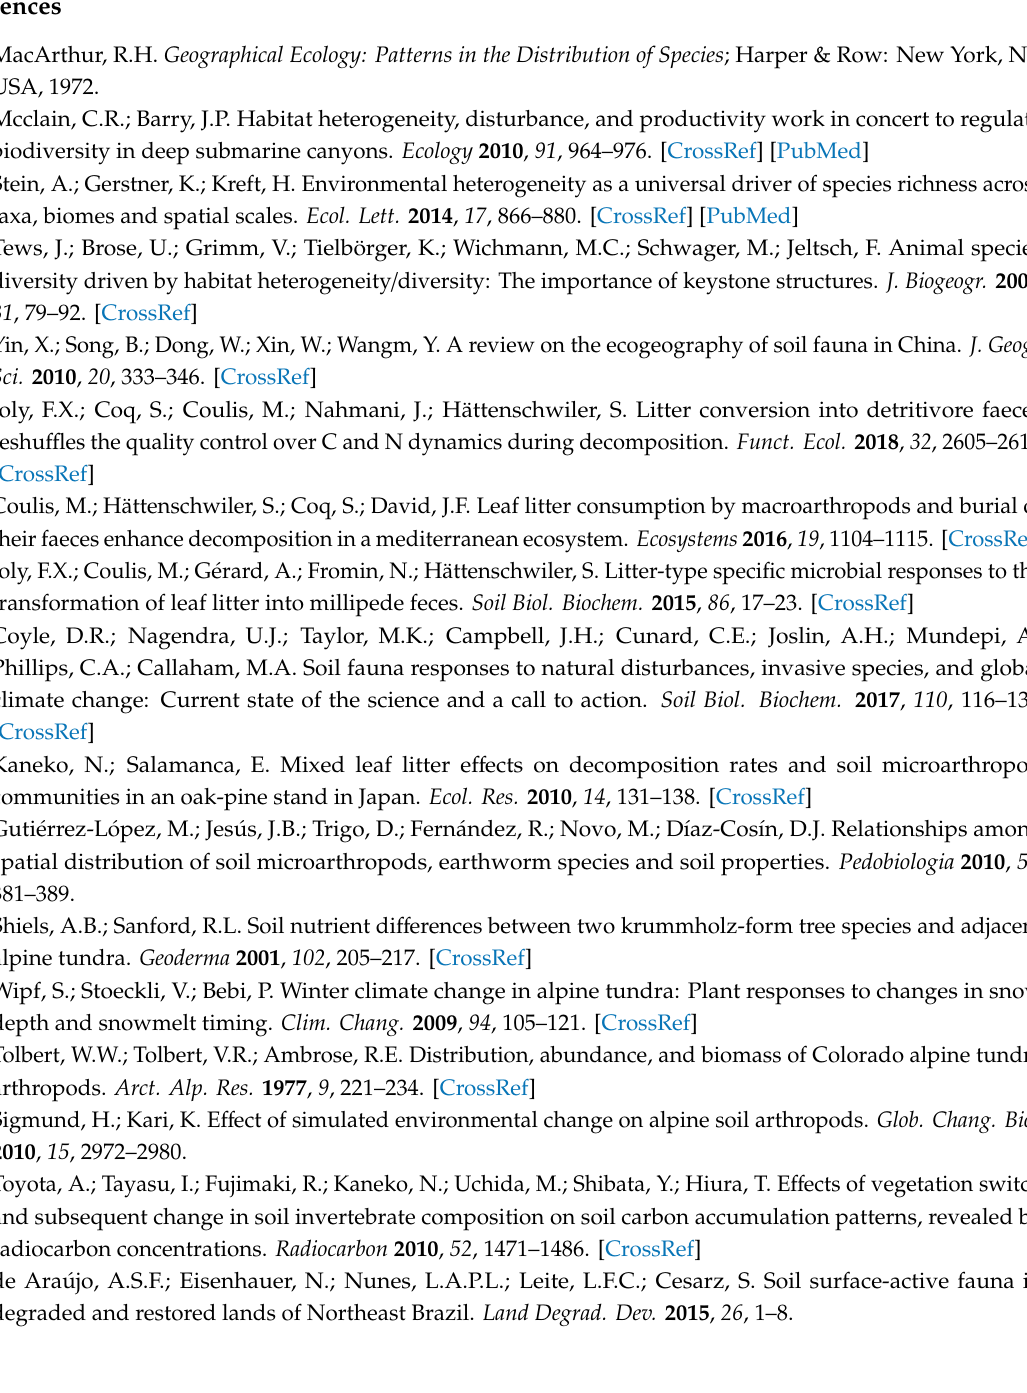
Table S1: Abundance (ind. m − 2 ) of soil arthropods in the various